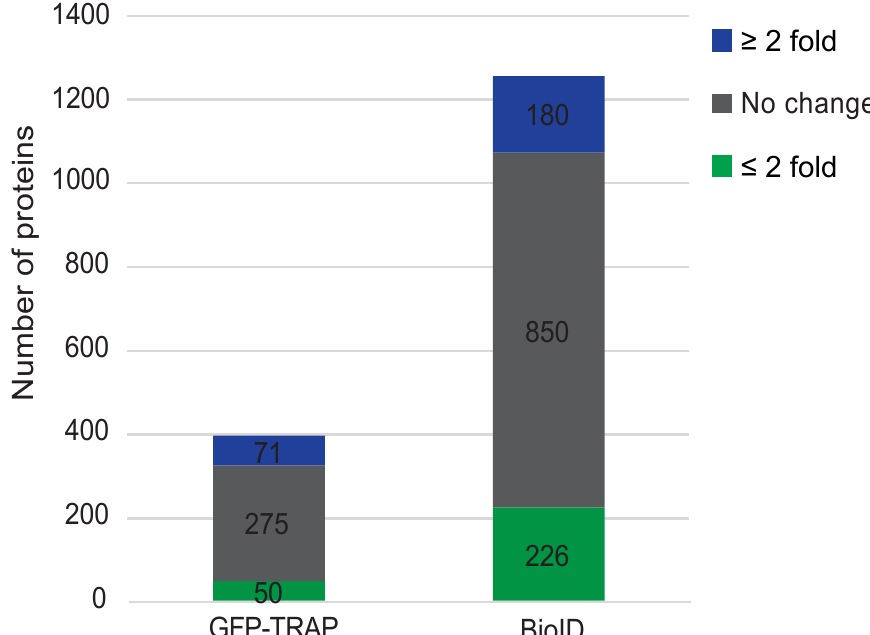
Figure 4. Probing the p53 β interactome by the GFP-TRAP system and p53 BioID. Left: Validation of hits from the GFP-TRAP system performed in SY5Y-inducible cell lines (left panels) and from p53 BioID system in MCF7 cells (right panels). Right: Bar graph shows a summary of the number of proteins identified in the GFP-TRAP and BioID systems. Blue: the number of proteins that bind ≥ 2 fold more to p53 β than to FLp53; green: the number of proteins that bind ≥ 2 fold less to p53 β than to FLp53; and grey: the number of proteins in between.